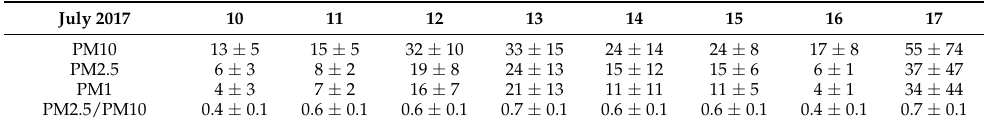
Table 1. Daily mean values of PM mass concentration ( µ g m − 3 ) measured by the OPC in the time period 10–17 July 2017 and corresponding PM2.5/PM10 ratio.